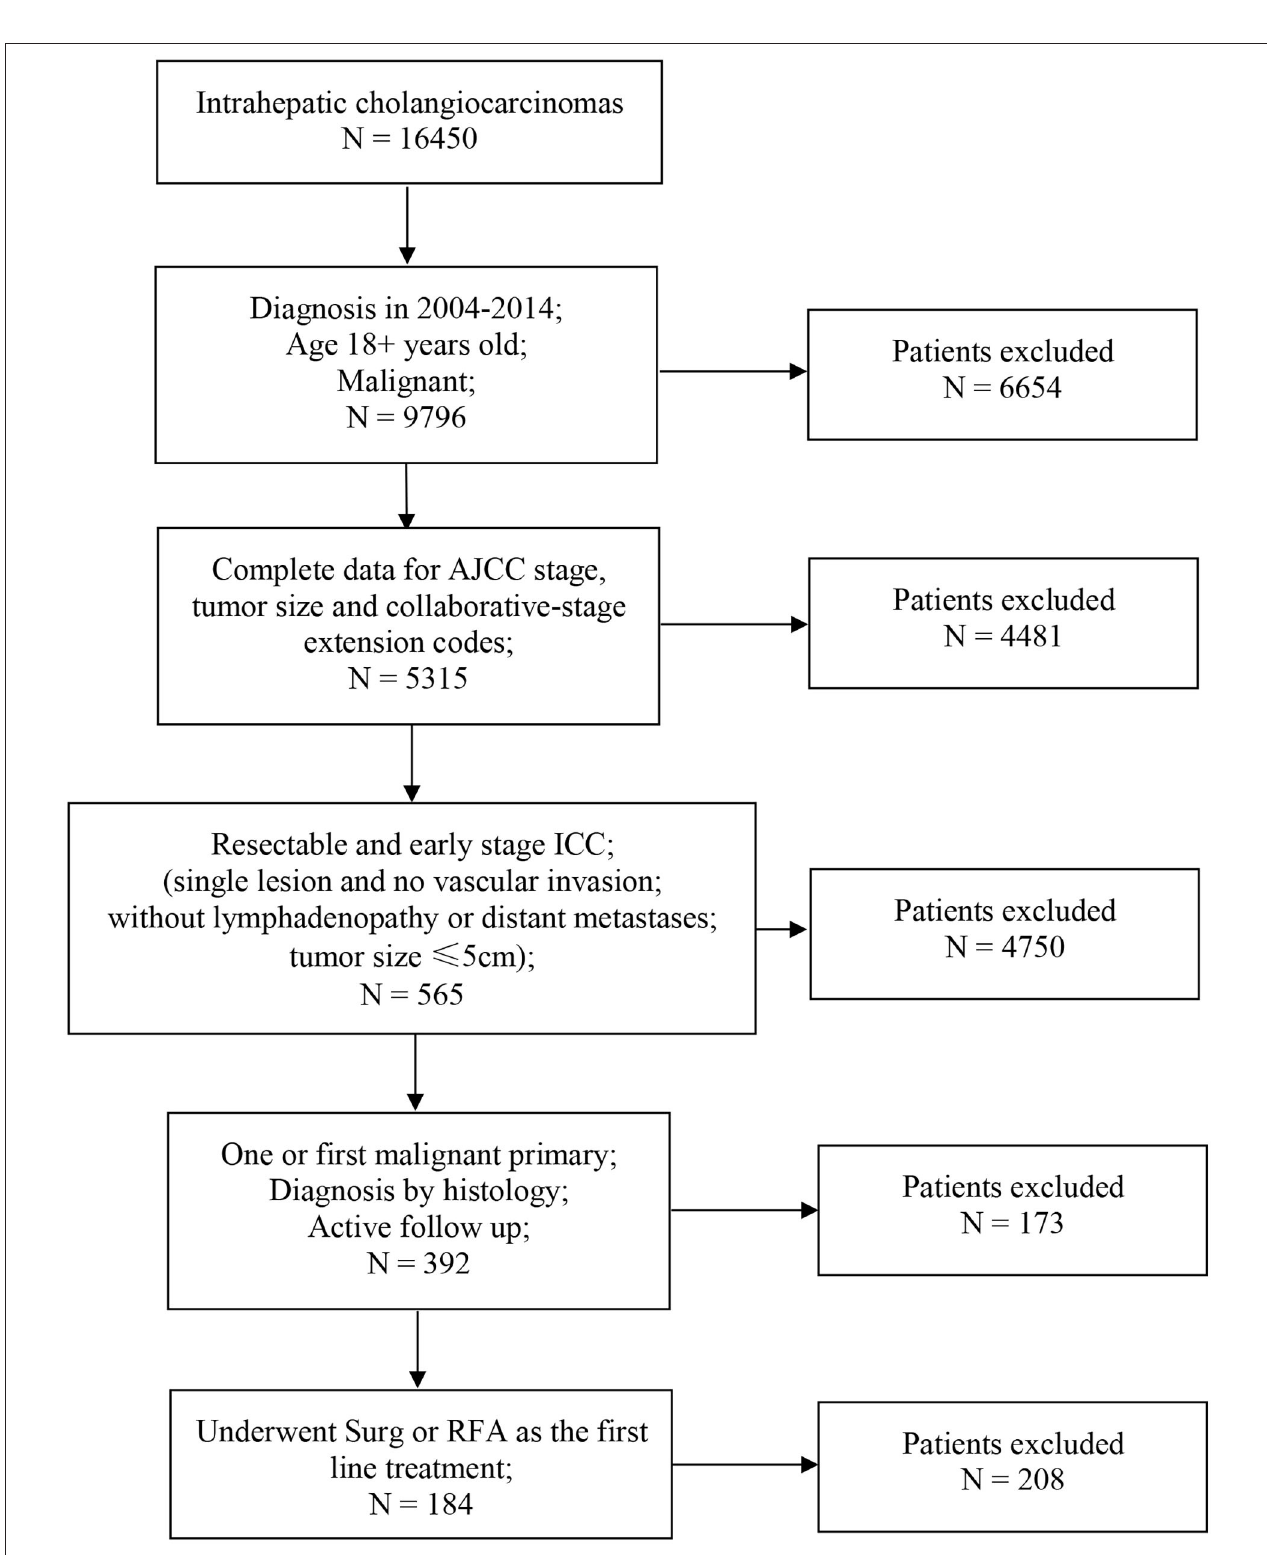
FIGURE 1 | Flowchart of patients selection. AJCC, American Joint Committee on Cancer; ICC, intrahepatic cholangiocarcinoma; Surg, surgical resection; RFA, radiofrequency ablation.